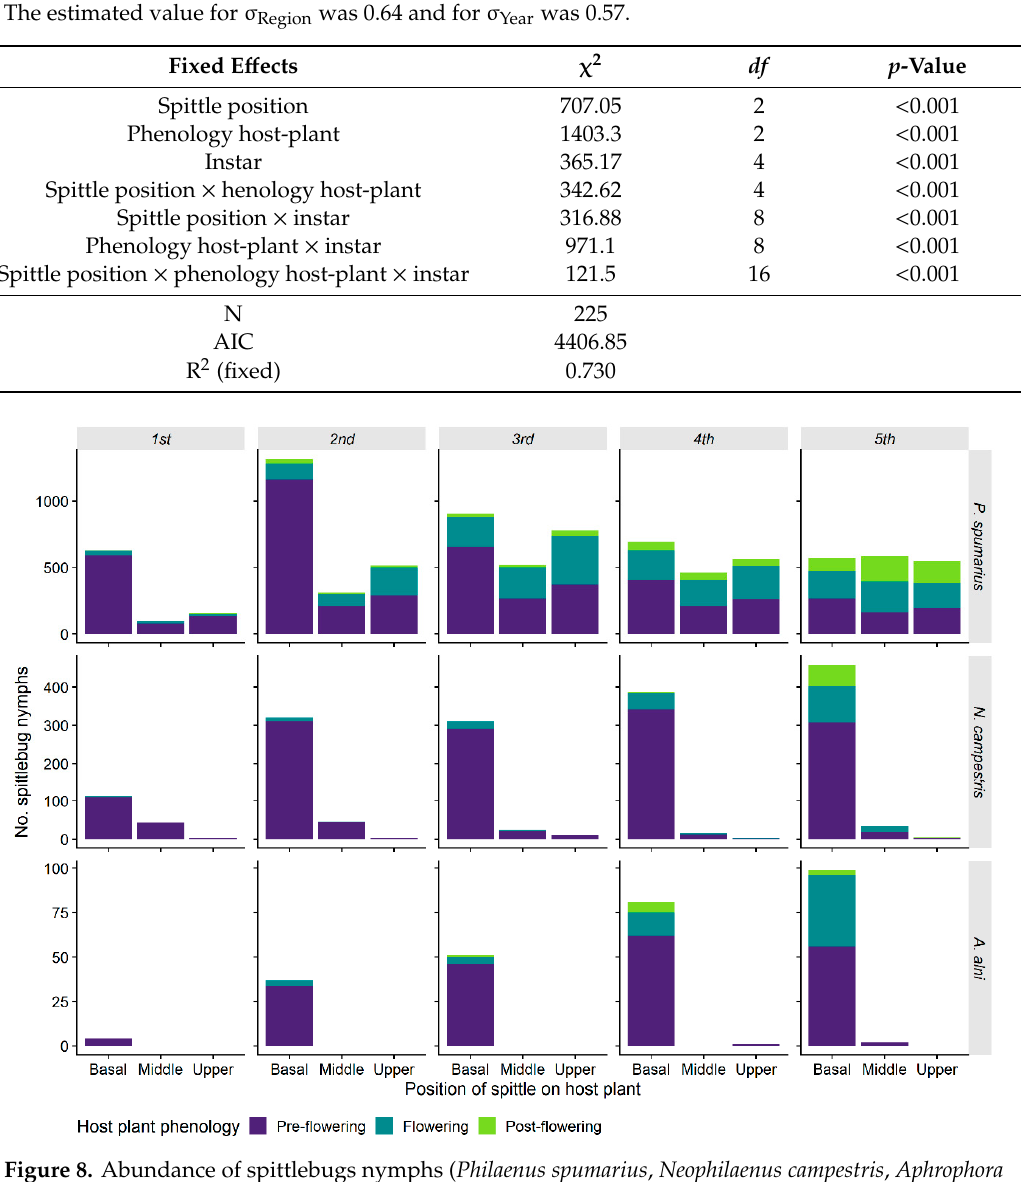
Figure 8. Abundance of spittlebugs nymphs ( Philaenus spumarius , Neophilaenus campestris , Aphrophora alni ) in relation to their instar, position on host-plant, and host-plant phenology. Table 2. Effects of fixed covariates on the abundance of Philaenus spumarius nymphs. Poisson GLMM of nymphal counts with covariates spittle position, phenology host-plant, and instar, and their interactions. The estimated value for σ Region was 0.64 and for σ Year was 0.57.